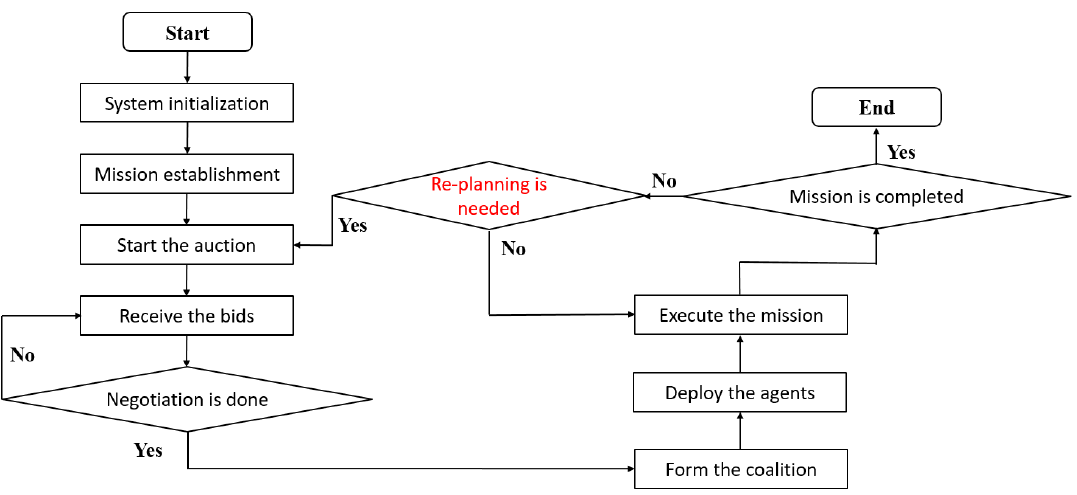
Figure 14. The mission re-planning mechanism.